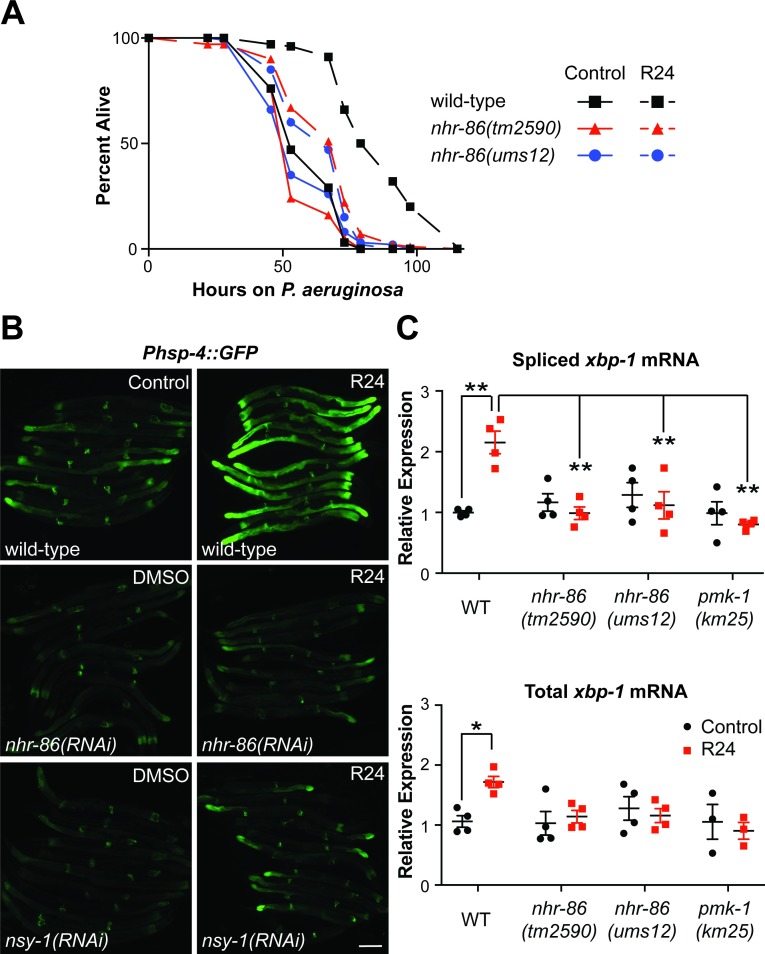
The immune response induced by nhr-86 protects C. elegans from P. aeruginosa infection.(A)
P. aeruginosa infection assays of C. elegans wild-type, nhr-86(tm2590) and nhr-86(ums12) treated with R24 or 1% DMSO (control) are shown. The difference in susceptibility to P. aeruginosa between R24-exposed wild-type and each of the mutant animals is significant (p<0.001 by the log-rank test). Data are representative of three trials. Sample sizes, mean lifespan, % lifespan extension conferred by R24 treatment in each background and p values for all trials are shown in S4A Table. Significance was determined using Kaplan-Meier survival curves and log-rank tests. (B)
C. elegans carrying the Phsp-4::GFP reporter were exposed to the indicated RNAi bacteria and transferred at the L4 stage to media supplemented with either R24 or control for approximately 18 hours. Scale bar equals 100 μm. (C) qRT-PCR was used to measure the spliced (active) and total xbp-1 mRNA in animals of the indicated genotype exposed to R24 or control. Comparisons were calculated using 2-way ANOVA with Bonferroni multiple comparisons test and * p<0.05 and ** p<0.0001. Data are the average of four independent replicates, each normalized to a control gene with error bars representing SEM. Data are presented as the value relative to the average expression from all replicates of the indicated gene in the baseline condition (wild-type animals exposed to control).